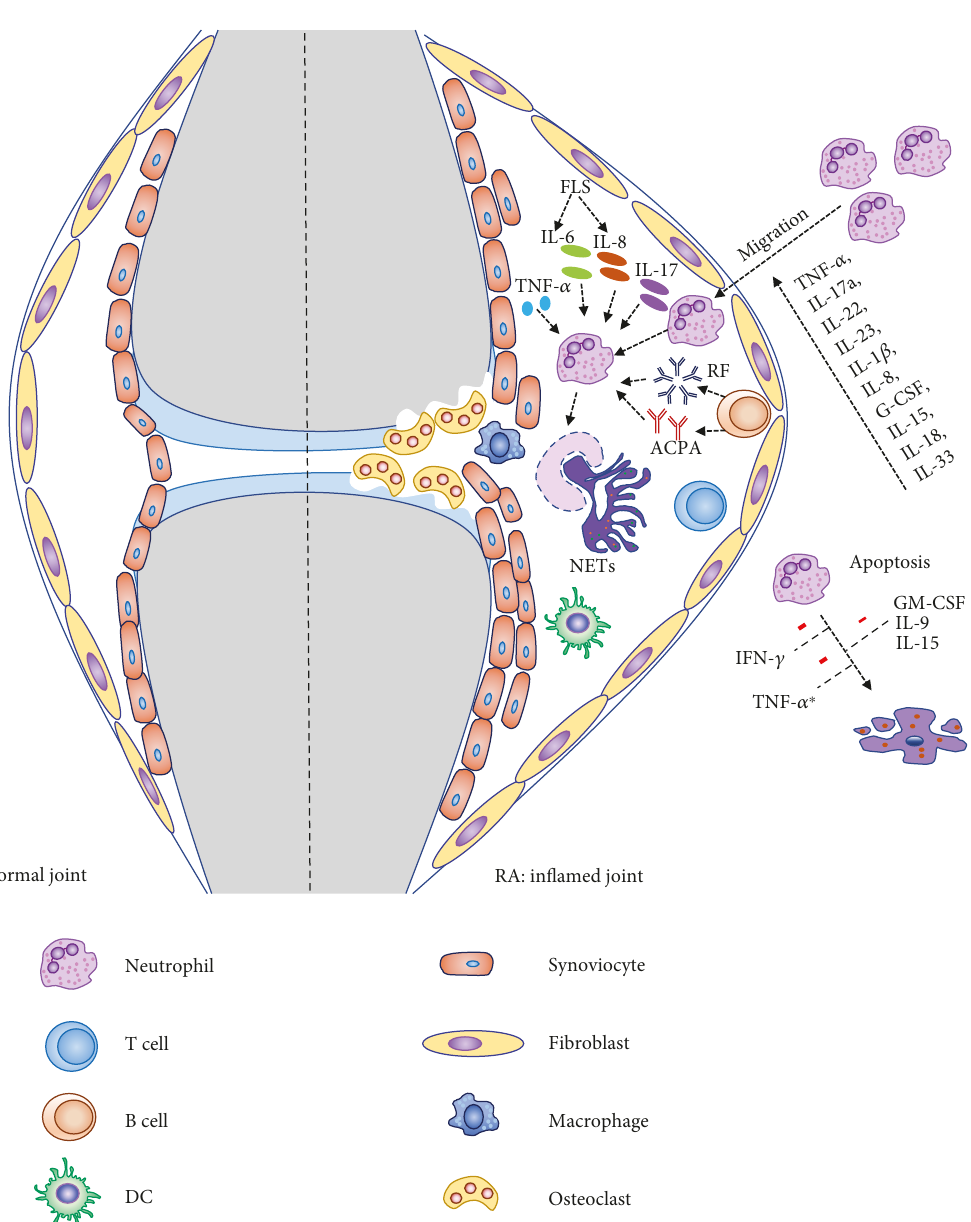
Figure 1: Role of neutrophil in the pathogenesis of RA. Proin fl ammatory cytokines in the joint can in fl uence the migration of neutrophils. Neutrophils are activated by immune complexes and in fl ammatory cytokines (TNF- α , IL-6, IL-8, and IL-17a) within the synovial fl uid, frequently causing enhanced NET formation in RA. In turn, NETs are served as a source of citrullinated autoantigens, further triggering the production of ACPA. Meanwhile, neutrophils undergo delayed apoptosis in an in fl ammatory milieu (GM-CSF, IL-9, IL-15, IFN- γ , and TNF- α ) leading to persistent in fl ammation and joint damage in RA. ∗